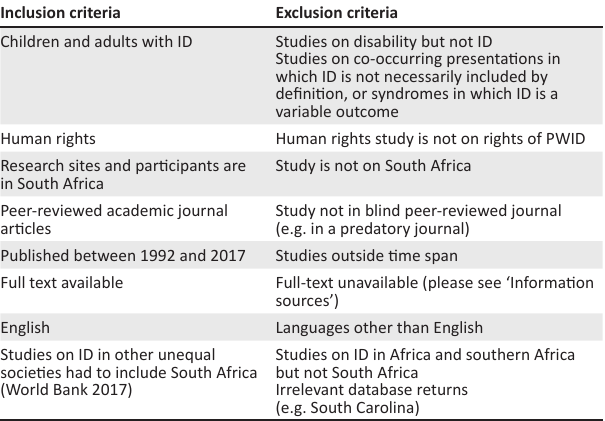
TABLE 1: Eligibility criteria for inclusion of studies in this scoping review. Inclusion